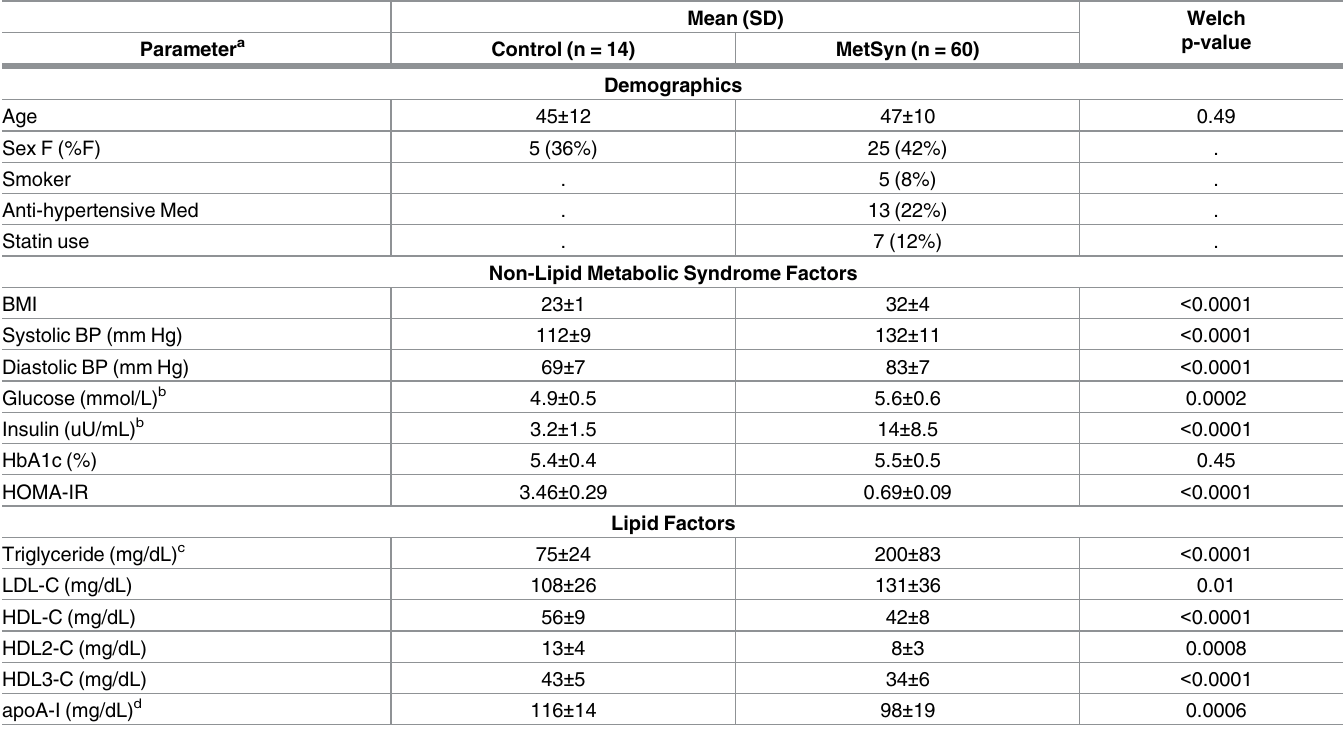
Table 1. Clinical characteristics of the study